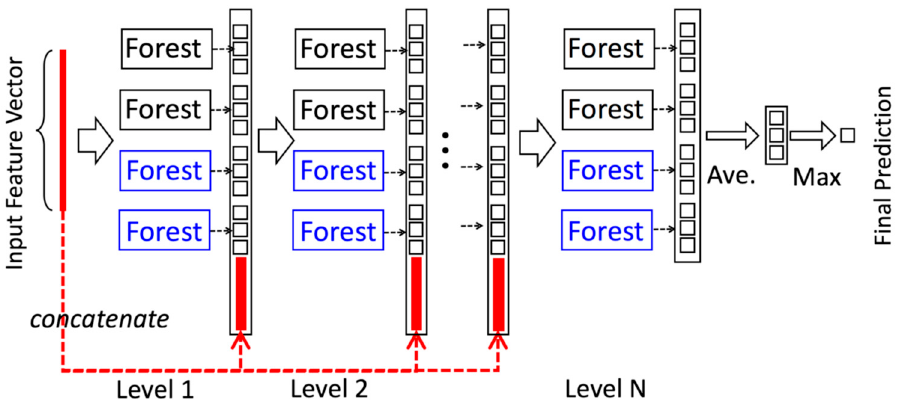
Figure 8. The cascade structure of gcForest.